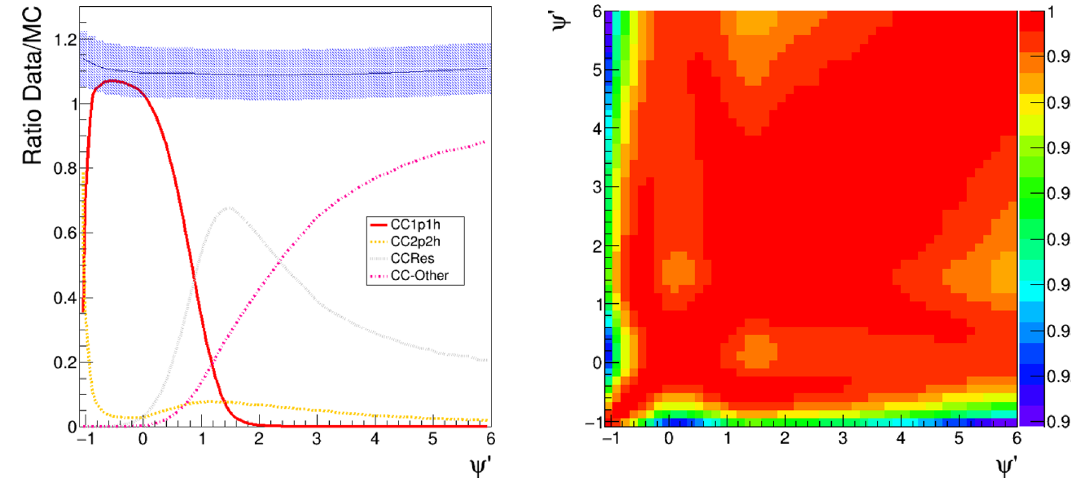
Figure 21 . Left: Data/MC ratio R ( ψ 0 ) calculated for the MINERvA CC inclusive cross-section, and split into the CC1p1h (red), CC2p2h (yellow), CCRes (gray) and CC-DIS (pink) contributions. Right: R ( ψ 0 ) correlation matrix computed for the MINERvA CC inclusive cross-sections.